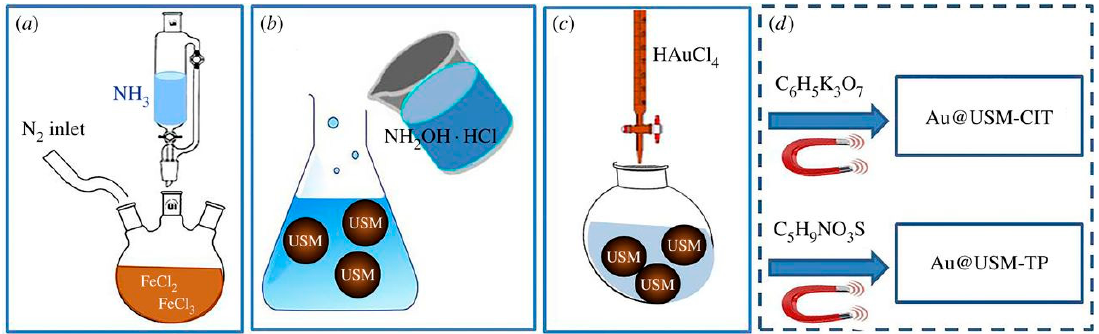
Figure 2. A scheme of the synthetic approach utilised ( a – d ) to obtain first ultra-small magnetite (USM) nanoparticles, followed by addition of gold to form Fe 3 O 4 @Au nanoparticles, and lastly the formation of the composites using either citrate or tiopronin as a reducing agent, and purification using magnetic separation. Reprinted with permission from [28]. Copyright The Royal Society Publishing, 2016.